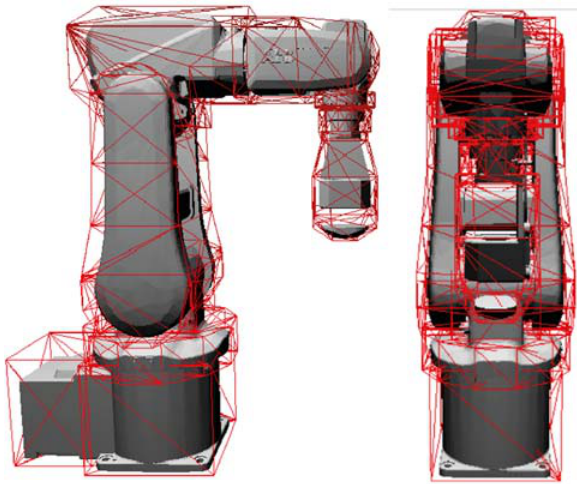
Figure 3. ABB IRB 120 manufacturer model together with the triangular-type element meshes used to compute the minimum distance to the manipulator in the collision and proximity s imulator.